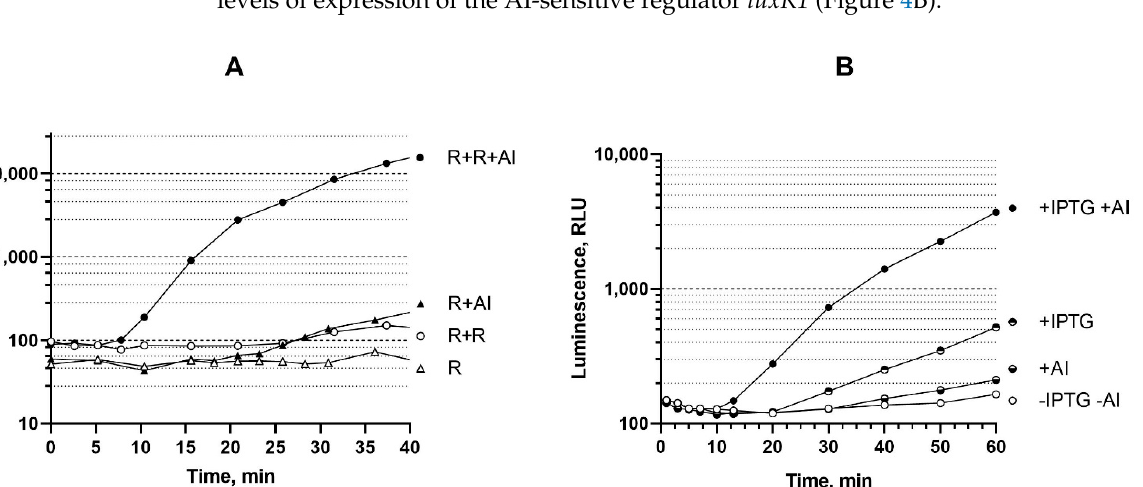
Figure 3. Dependence of base luminescence of LuxR-based biosensors on regulatory gene dosage and its expression level (without AI addition). Biosensor strains and corresponding signatures are the same as in previous figures. Graph shows averages of three independent replicates.